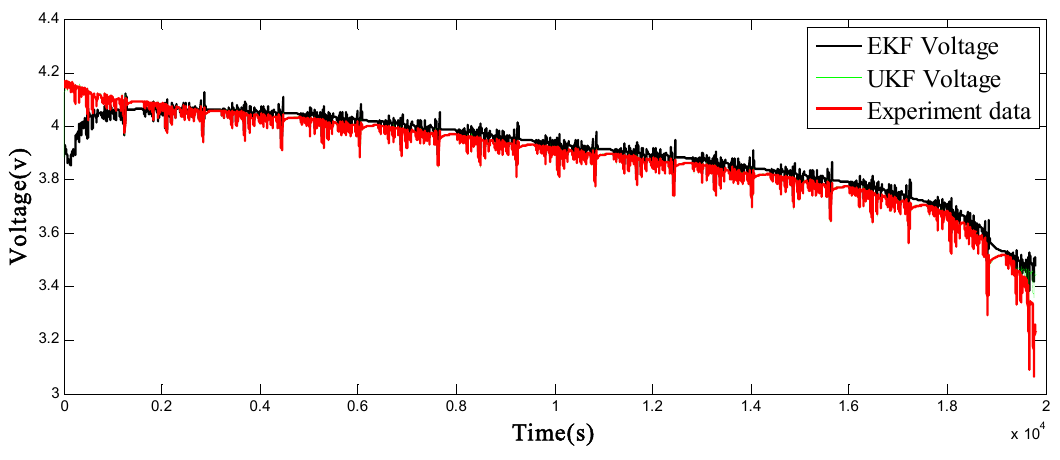
Figure 10. Voltage profiles of 10 consecutive BJDC cycles.